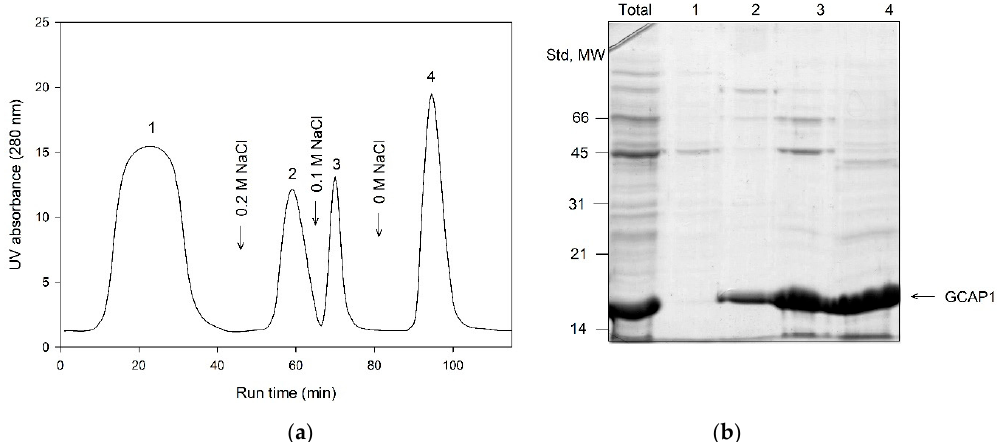
Figure 4. Primary purification of GCAP1 using hydrophobic interaction chromatography on Toyopearl Butyl. ( a ) Representative chromatographic profile. The numbers 1–4 denote fractions obtained